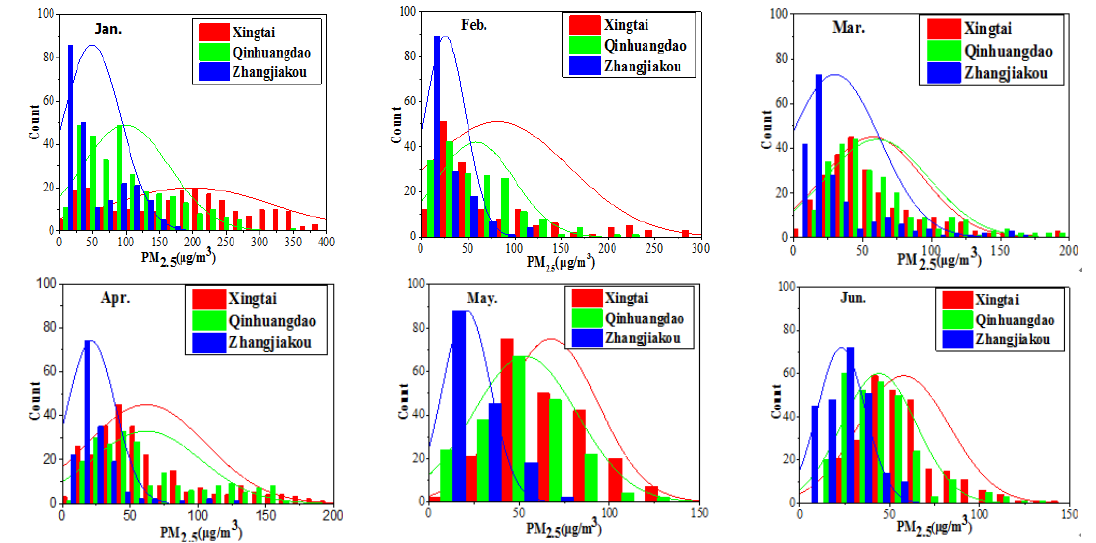
Figure 2. Histogram statistics of PM 2.5 concentrations from Jan. to Jun. 2017 in Xingtai-Nanhe, Qinhuangdao-Changli, and Zhangjiakou-Huaian, respectively.